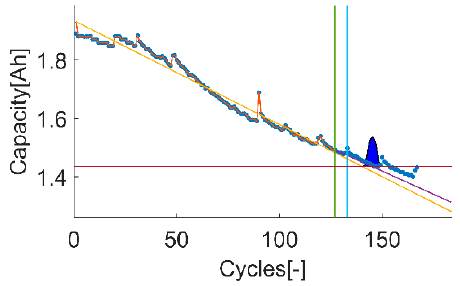
Figure 17. Time-instant figure of test 1 on t 118 .